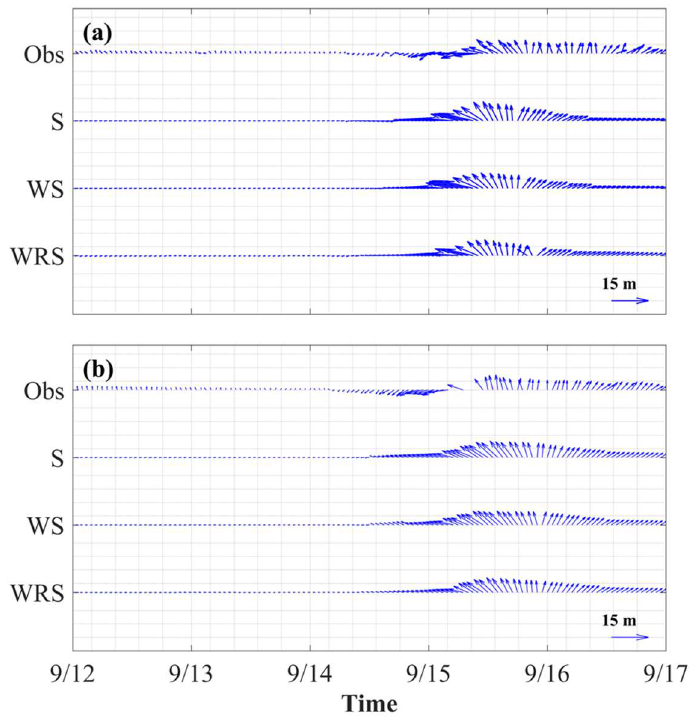
Figure 18. Comparison of observed and simulated wave direction (vectors) at ( a ) Buoy 1; and ( b ) Buoy 4.